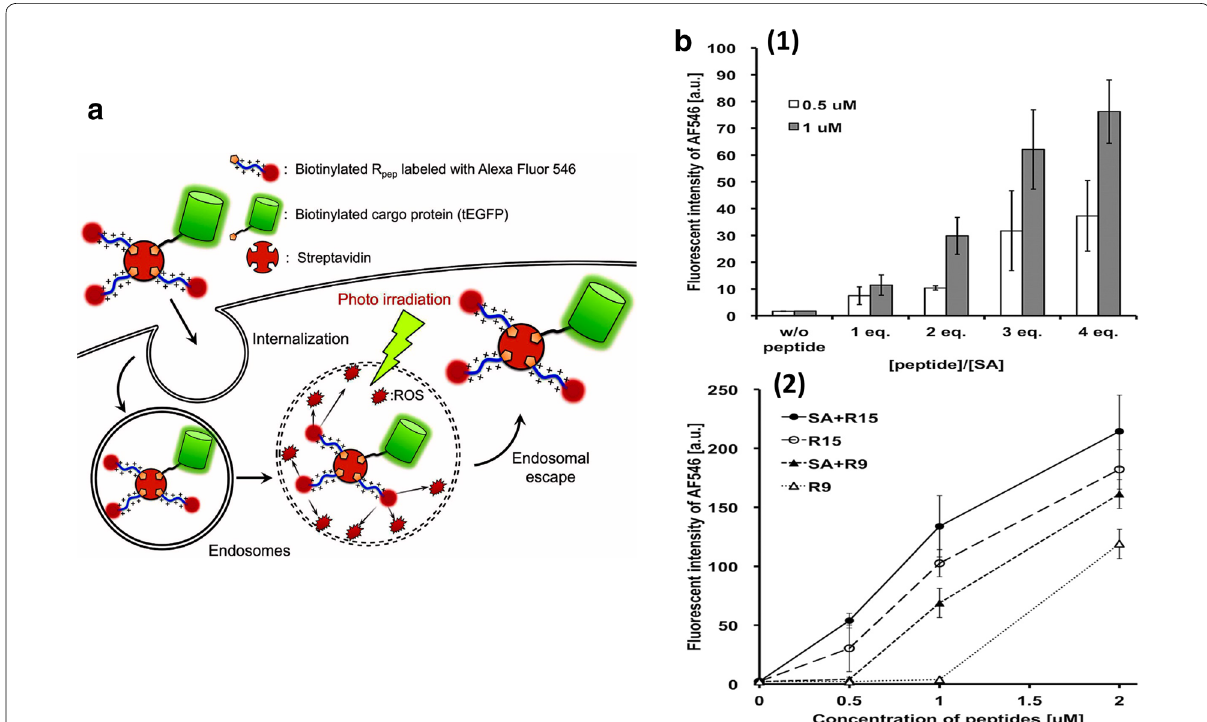
Fig. 3 Protein transduction using the streptavidin based nano-carrier. a Schematic illustration of protein transduction using the streptavidin based nano-carrier. b ( 1 ) Effect of the conjugation ratio of R15 peptides to SA on the fluorescence intensity of HeLa cells after uptake of AF546-labeled SA–R15 complex. ( 2 ) Effects of the length of R pep on the fluorescence intensity of HeLa cells after uptake of AF546-labeled R pep itself ant SA–R pep complex (Figure reproduced with permission from: Ref. [61]. Copyright (2015) with permission from